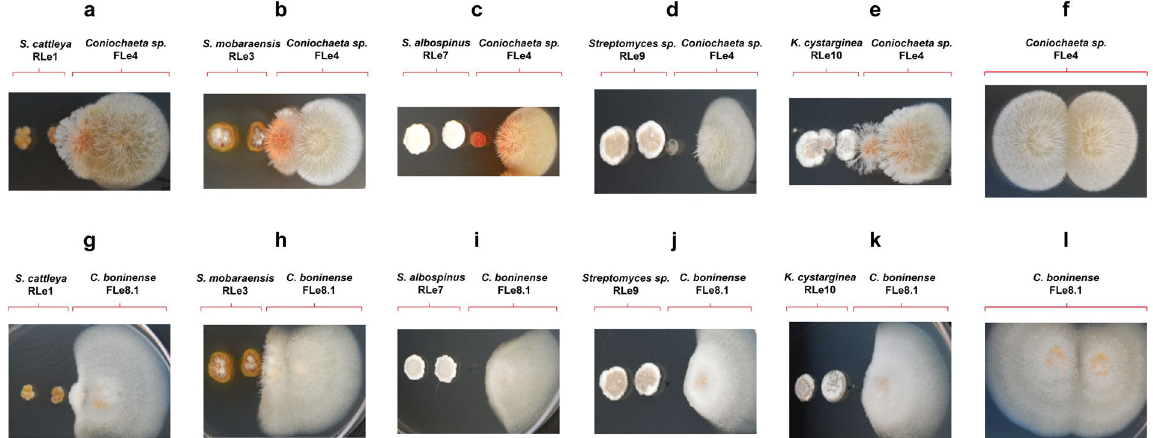
Figure 1. Pairwise inter-kingdom interactions involving endophytic fungi Coniochaeta sp. FLe4 and C . boninense FLe8.1 with endophytic actinobacteria from L . ericoides . Actinobacteria: S . cattleya RLe1, S . mobaraensis RLe3, S . albospinus RLe7, Streptomyces sp. RLe9, K . cystarginea RLe10. Fungi: Coniochaeta sp. FLe4 and C . boninense FLe8.1. Every interaction involved two colonies of each microorganism. Photos taken after 96 hours of